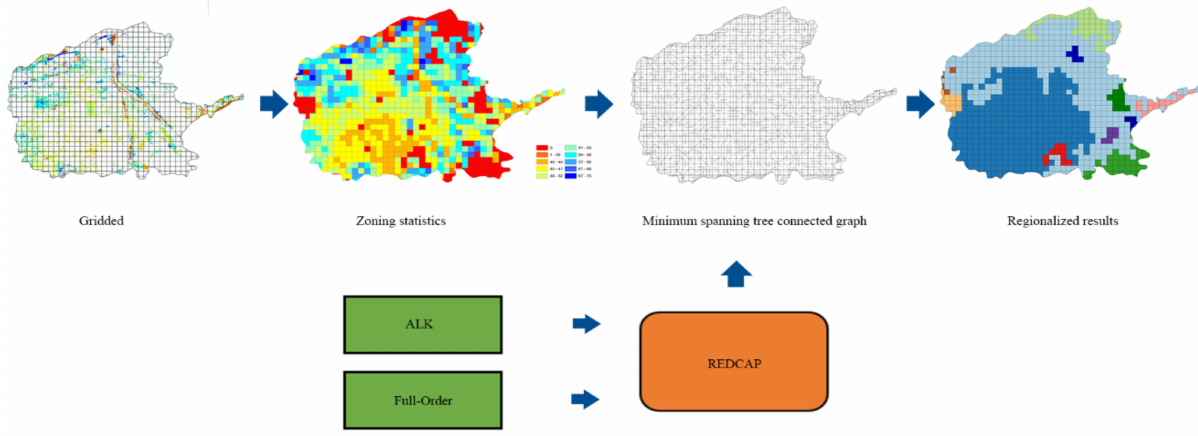
Figure 7. Regionalization process diagram.